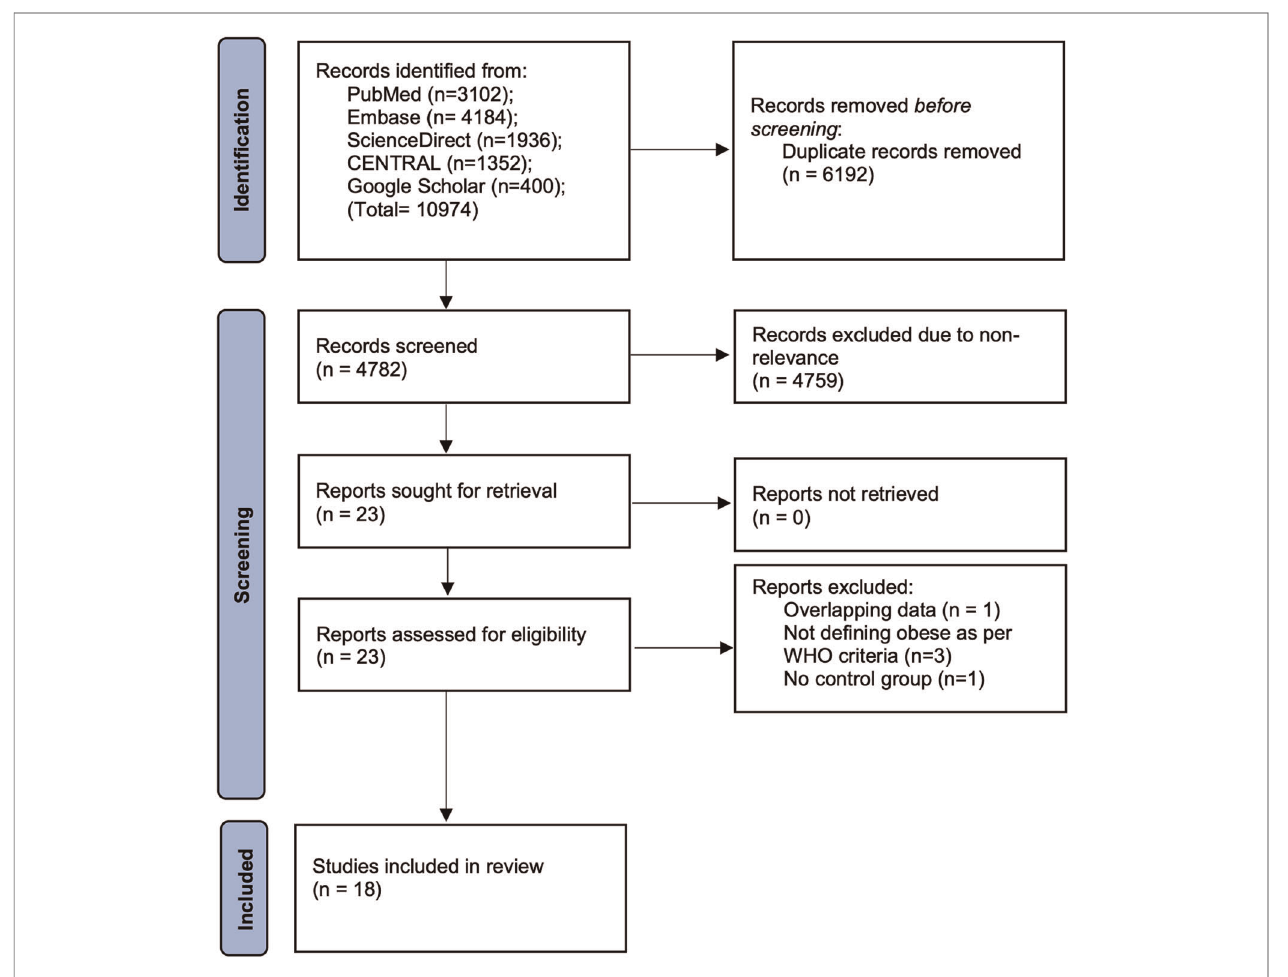
FIGURE 1 | PRISMA fl ow-chart of the